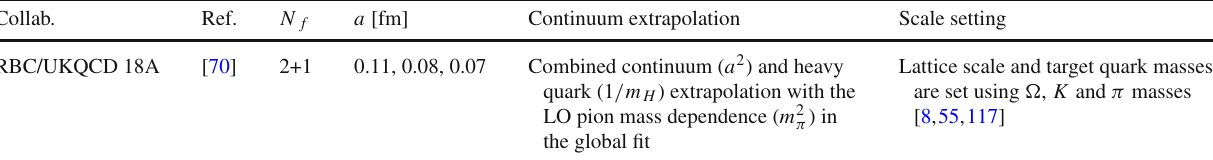
Table150 Continuumextrapolations/estimationoflatticeartifactsindeterminationsoftheneutral B -mesonmixingmatrixelementsfor N f = 2 + 1 simulations